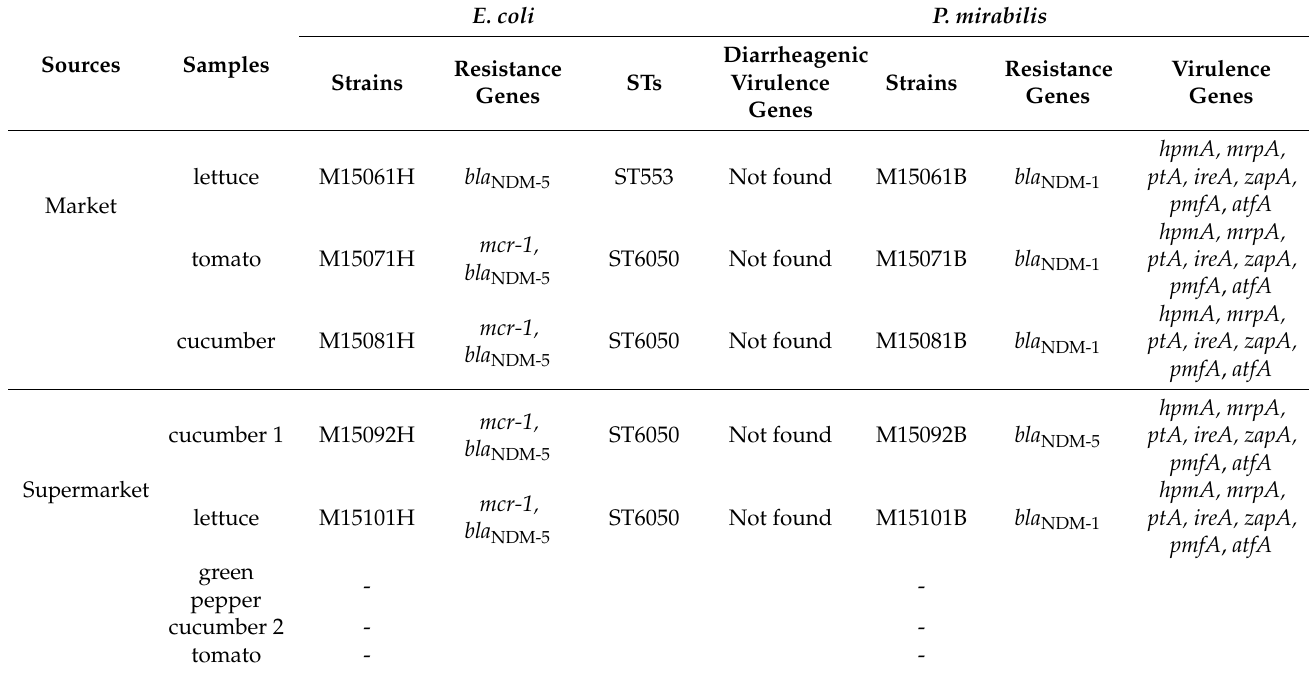
Table 1. Origins, resistance genes and virulence genes of five P. mirabilis carrying bla NDM and five bla NDM -positive E. coli from the same five fresh